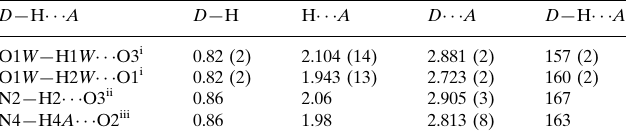
Hydrogen-bond geometry (A˚ , (cid:2) ). D —H (cid:1)(cid:1)(cid:1) A